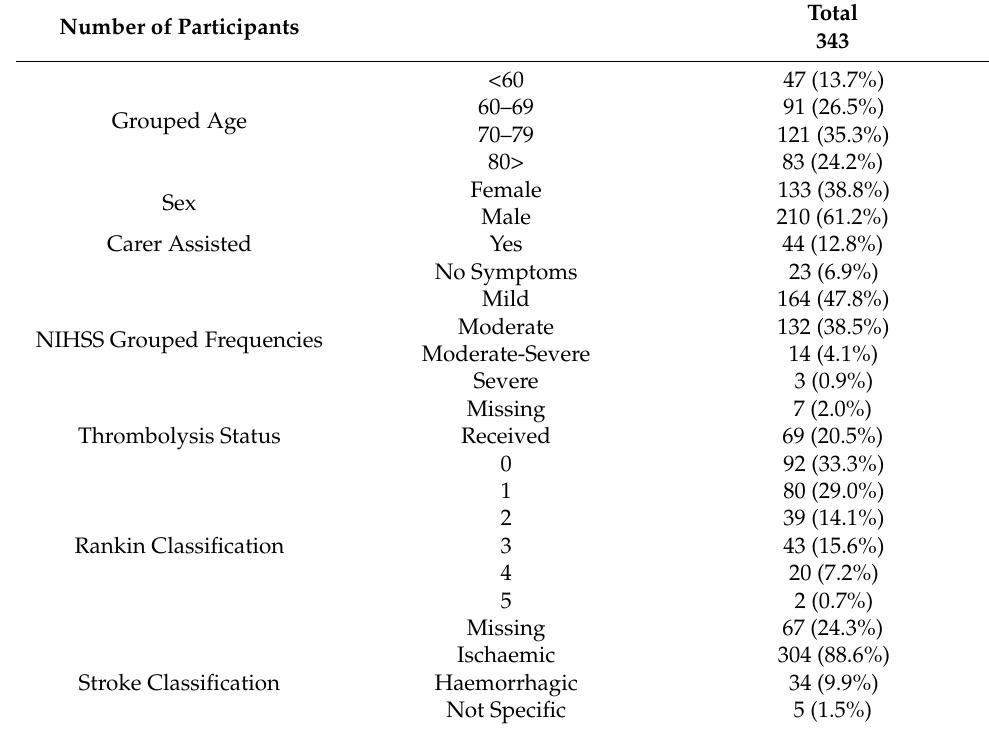
Table 1. Baseline demographics and descriptive analyses of all